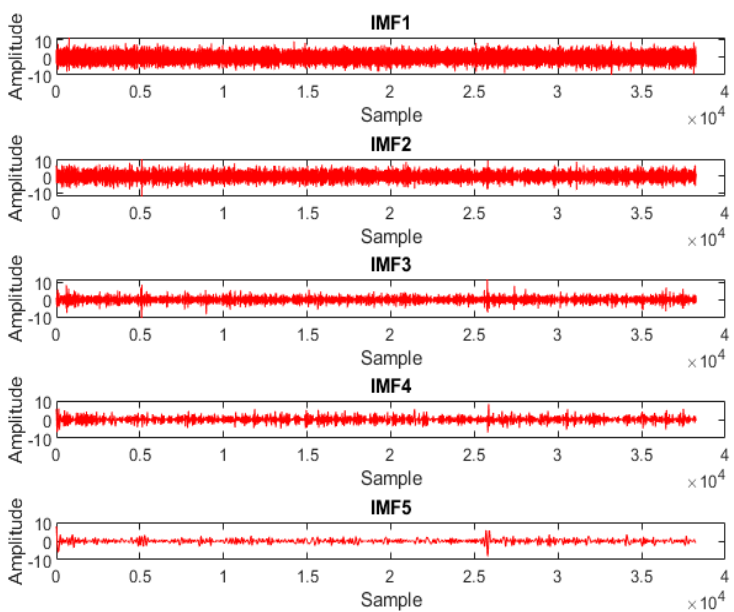
Figure 3. First five IMFs using EMD of the F4 EEG channel belonging to the subject number 10 (according to the G1 label).